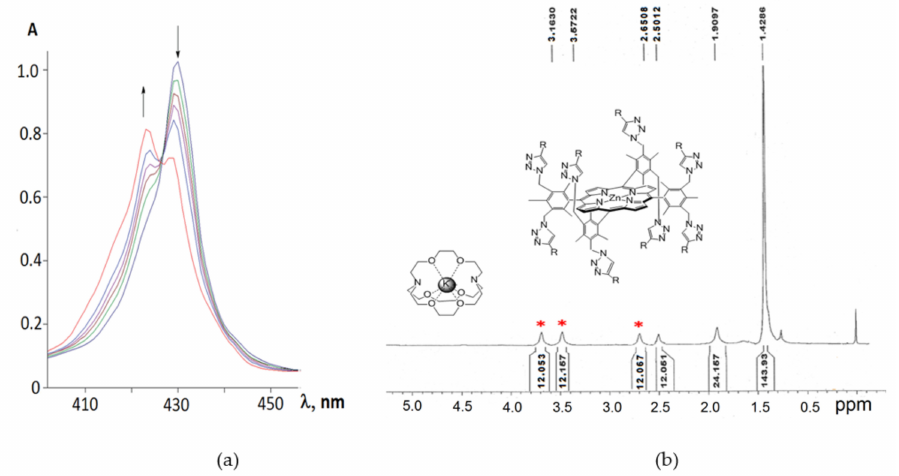
Figure 27. Changes in the absorption spectra in the [ 79-Cr1 ]–K + system, [ 36 ] = 1.2 × 10 − 6 M, [ L ] = 0 ÷ 2.9 × 10 − 5 M ( a ); 1 H-NMR spectrum of the [ 79-Cr1 ]– K + system in CDCl 3 (300 MHz, 298 K) ( b ); *—the signals of equivalent protons of the central (-OCH 2 CH 2 O-, 12 H) and lateral [-OCH 2 - (12 H), and -CH 2 N- (12 H)]